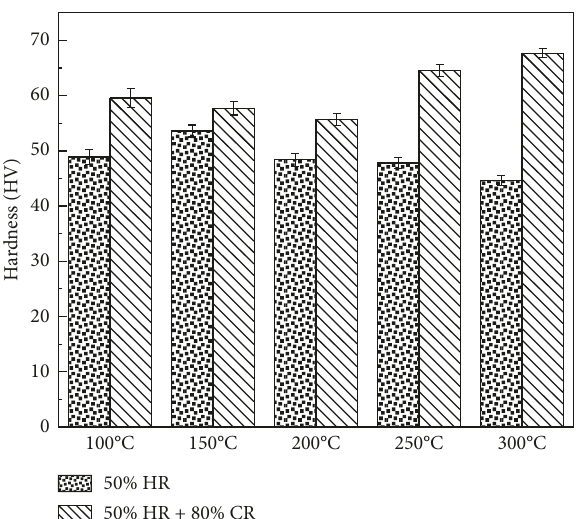
Figure 4: Hardness values of the specimens after hot rolling and hot rolling plus cold